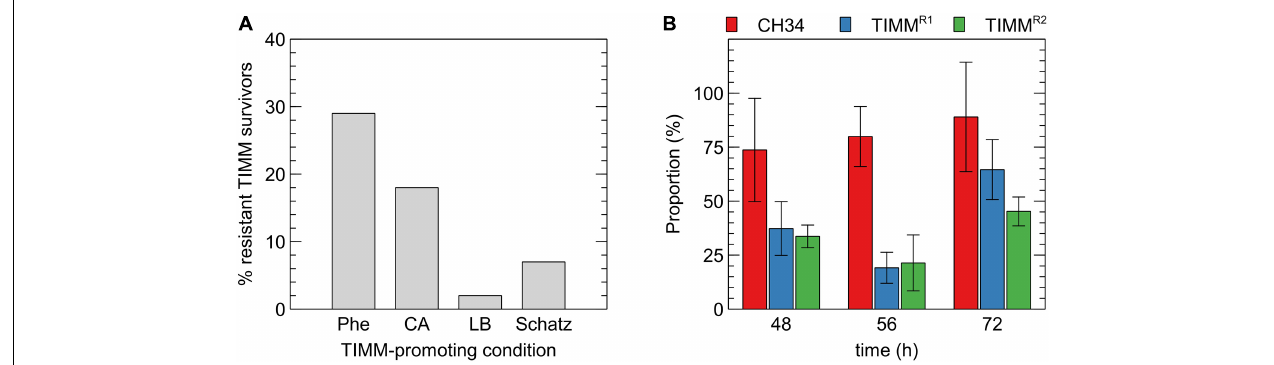
FIGURE 2 | Characterization of TIMM survivors. (A) Inherited resistance of 100 TIMM survivors, originally isolated on MM284 containing 0.5% (w/v) L -phenylalanine, to different TIMM-promoting conditions as determined by the ratio of viable count at 37 to 30 ◦ C. Phe: L -phenylalanine, CA: casamino acids. (B) Relative fitness of the parental strain CH34 (red), CH34-TIMM R 1 (blue) and CH34-TIMM R 2 (green) in MM284 at 30 ◦ C, as determined by the ratio of viable count of the strains to CH34-Km R in function of